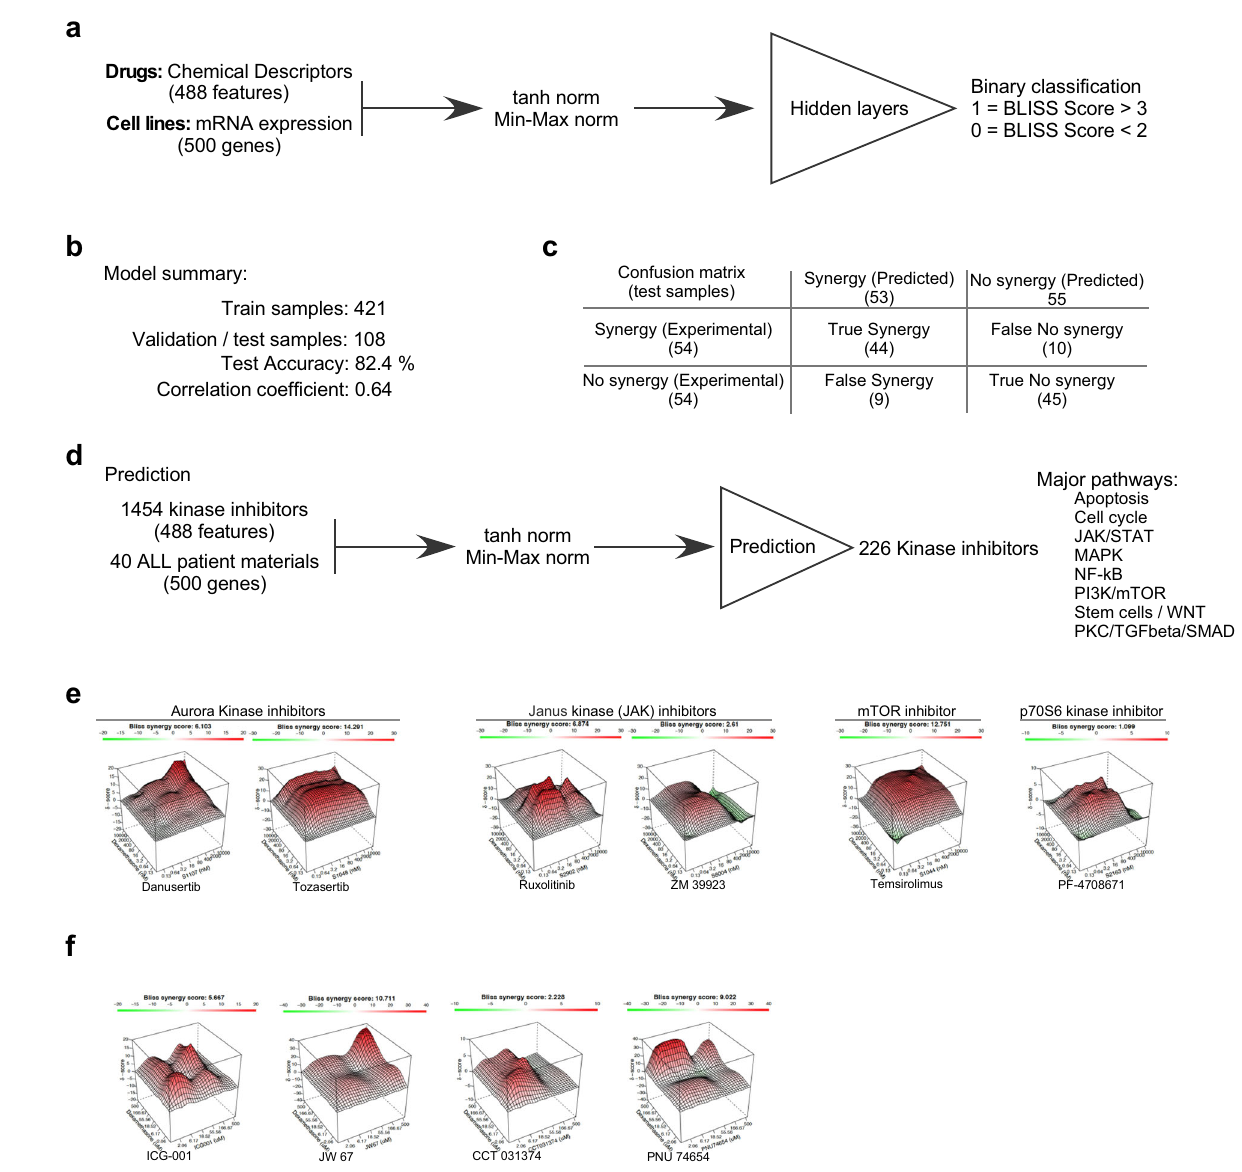
Fig. 6 The synergy between dexamethasone and kinase inhibitors. a Using the same 500-gene signature and drug synergy data from the DrugComb database, a deep learning binary classi fi cation model was developed to predict synergy between dexamethasone and other inhibitors. b Model performance was tested using 108 test samples. c Confusion matrix showing the model ’ s performance using 108 test samples. d In silico synergy prediction between dexamethasone and 1454 kinase inhibitors using the deep learning model. e In vitro synergy measurement between dexamethasone and kinase inhibitors in TANOUE cells using Cell Titer Glo after 48 h of incubation with drug combinations. The fi gure shows representative kinase inhibitors. f In vitro synergy measurement between dexamethasone and β -catenin inhibitors in TANOUE cells using Cell Titer Glo after 48 h of incubation with drug